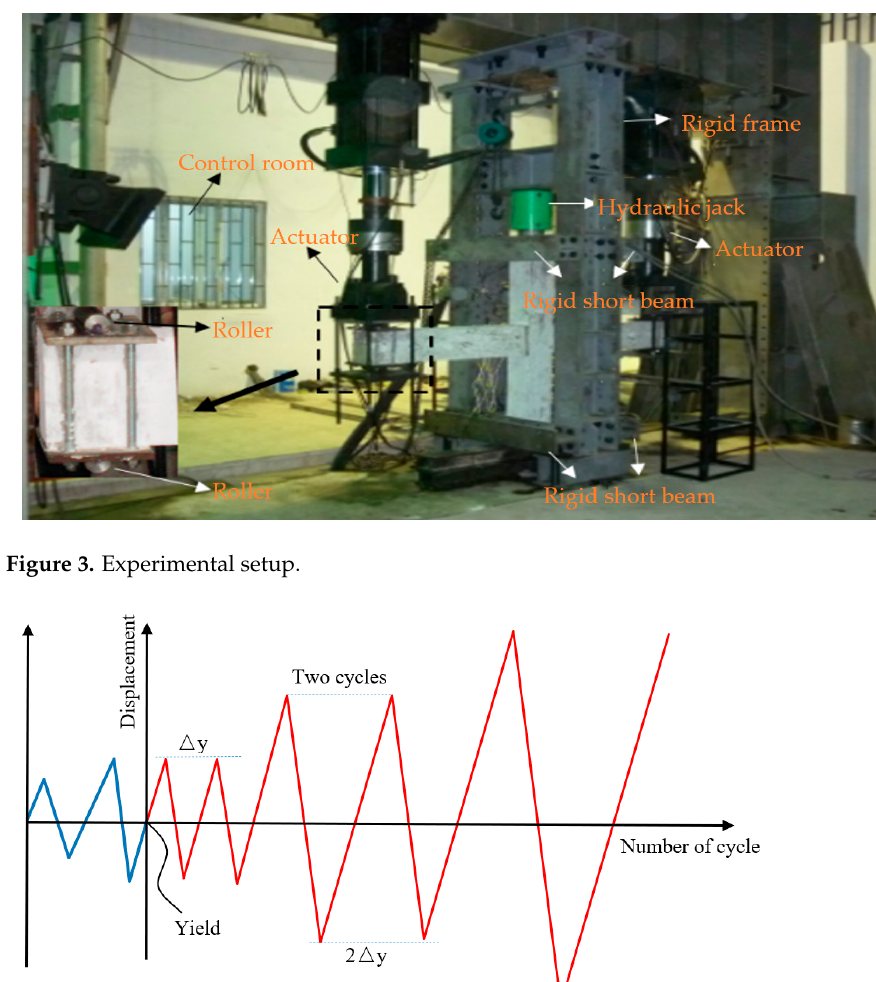
Figure 4. Loading history.